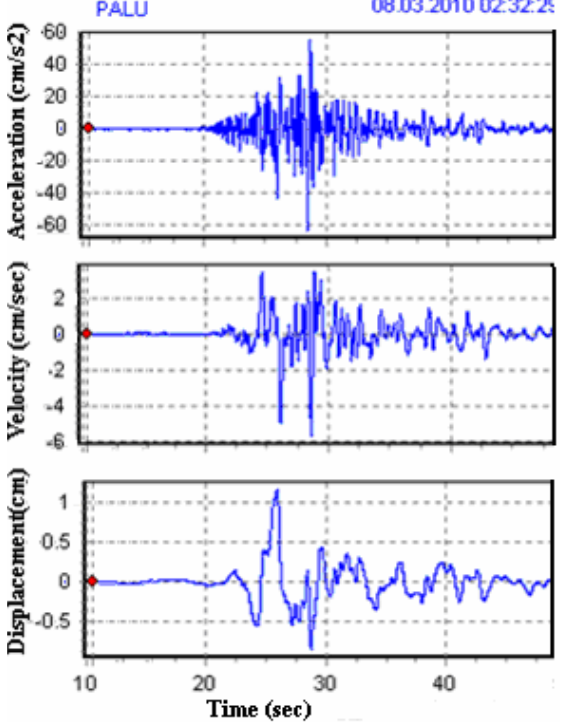
Fig. 3. Palu station acceleration records (ED, 2010).